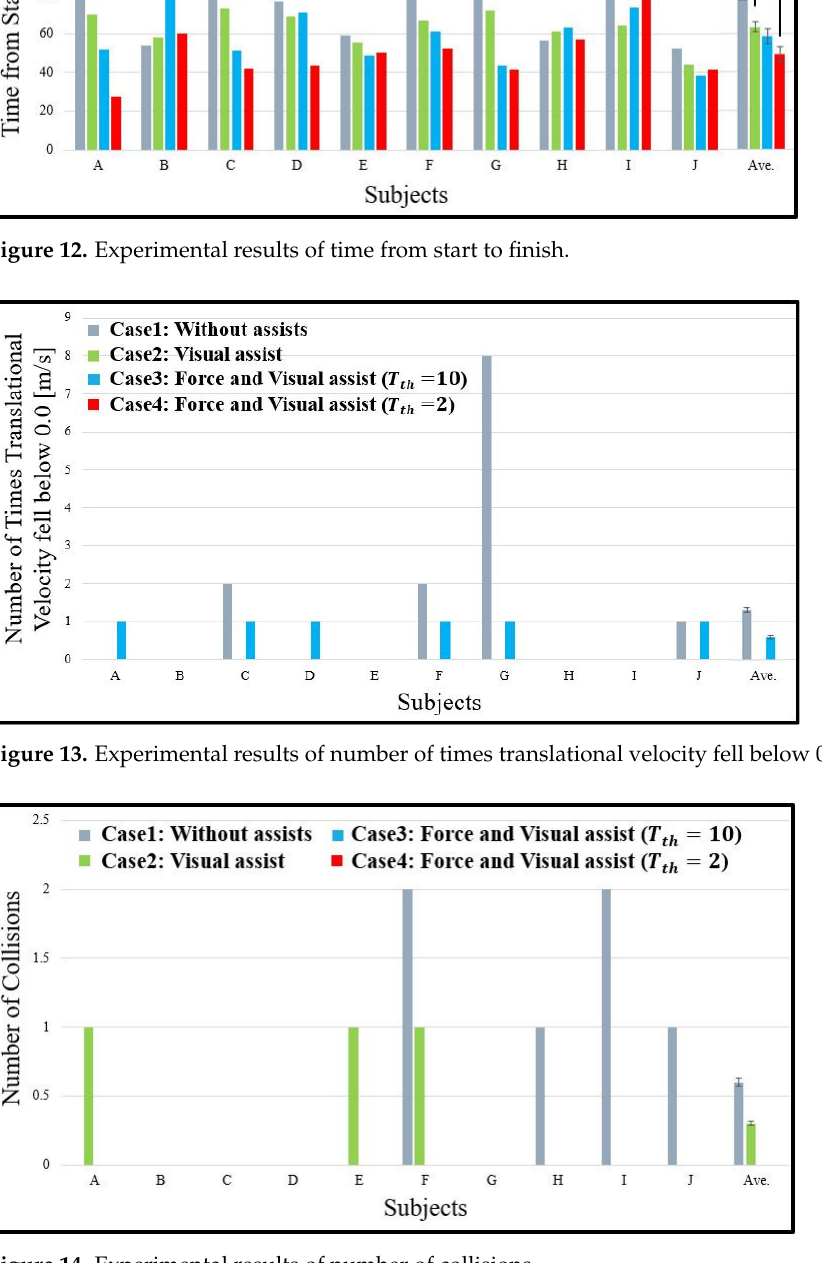
Figure 14. Experimental results of number of